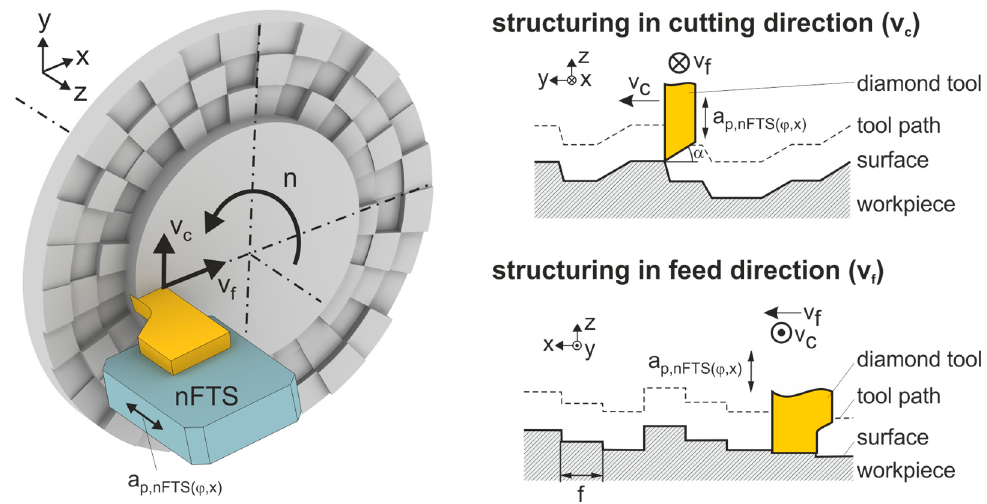
Figure 1. Process principle for diamond machining of holograms with varying structure angles.